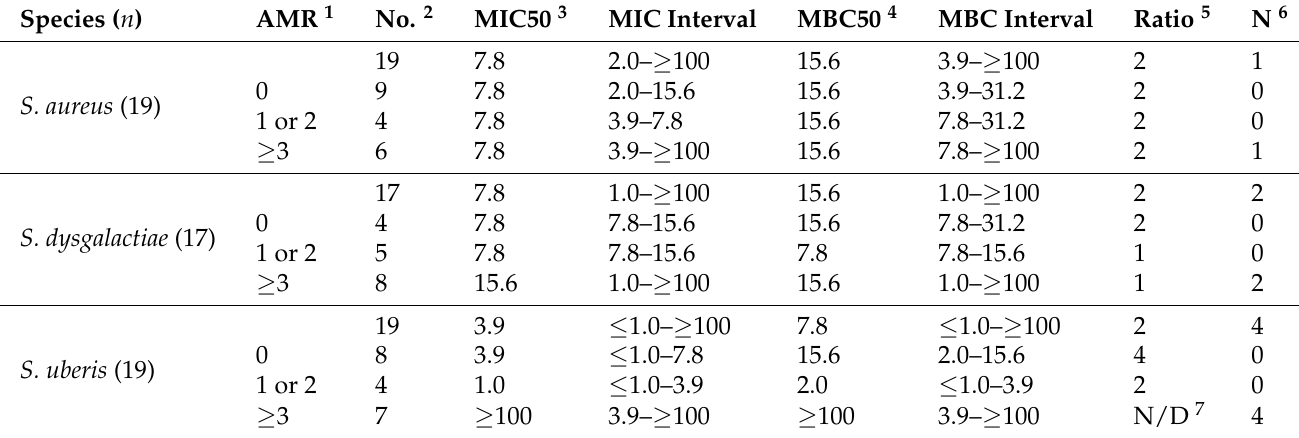
Table 2. MIC and MBC intervals, as well as MIC50 and MBC50 ( µ g/mL) values, of nisin against Staphylococcus and Streptococcus causing